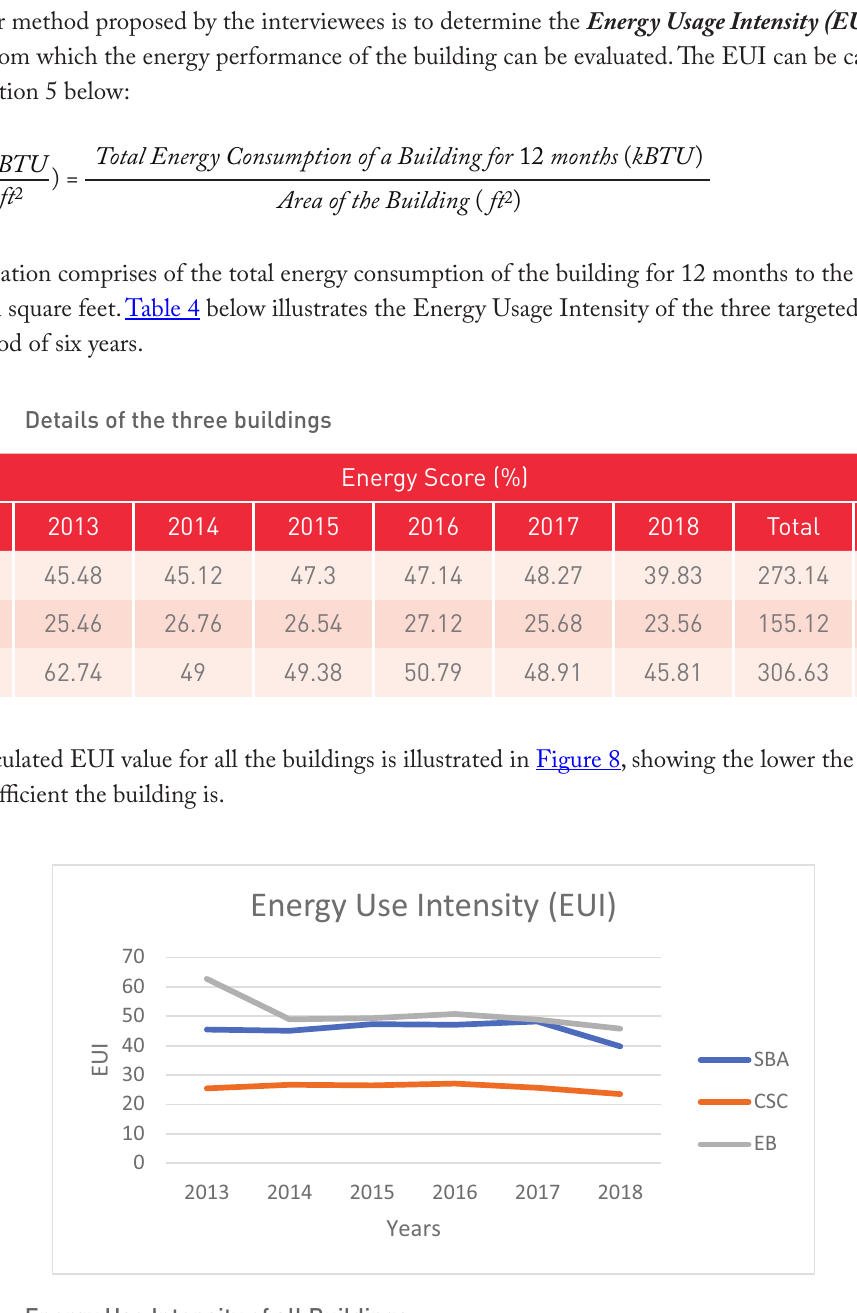
Figure 8. Energy Use Intensity of all